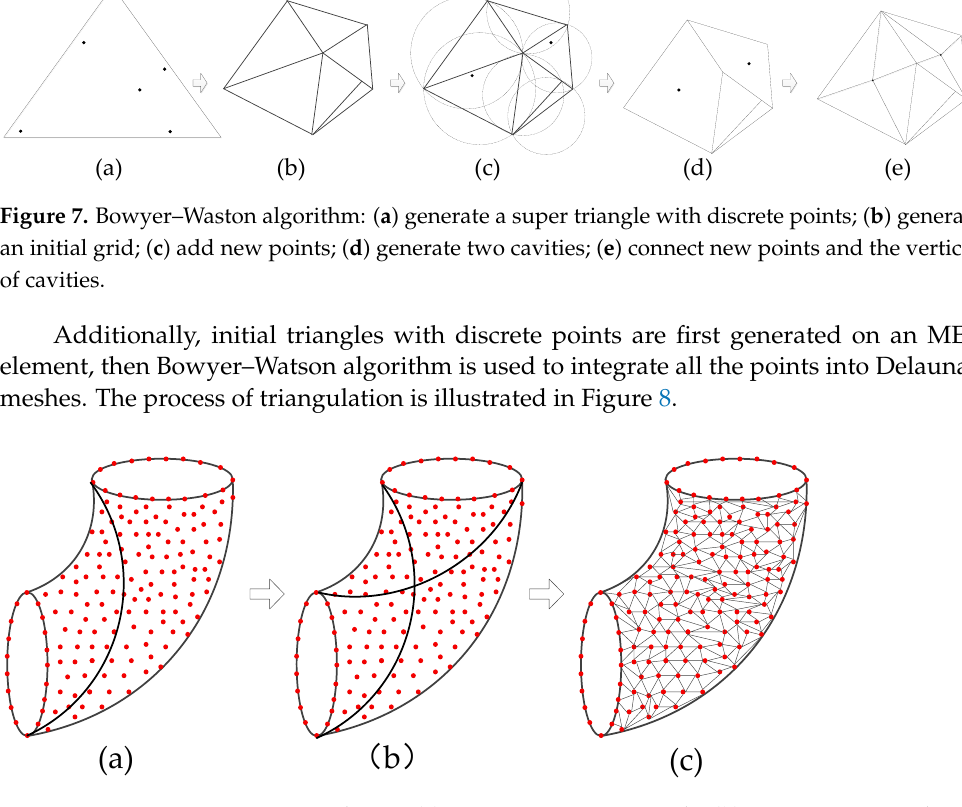
s k C i Figure 9. The distribution of the cross-sections of an MEP element. Because center points of representative sets represent the spatial position of an MEP element, this study utilizes the center point as the representative point. Without loss of generality, the MEP element with unchanged cross-section normal vectors utilizes repre- sentative points (the center points) of two outer cross-section curves to build the repre- sentative edge. The element with mutative cross-section normal vectors requires extract- ing representative points of each cross-section curve to obtain representative edge (edg- es). In fact, representative points of outer cross-section curves can be obtained by extract- ing boundary points of triangular meshes. To facilitate the description of boundary extraction, it is imperative to define the ad- jacent triangle mesh and the adjacent points [35]. Take any point p of an MEP element,